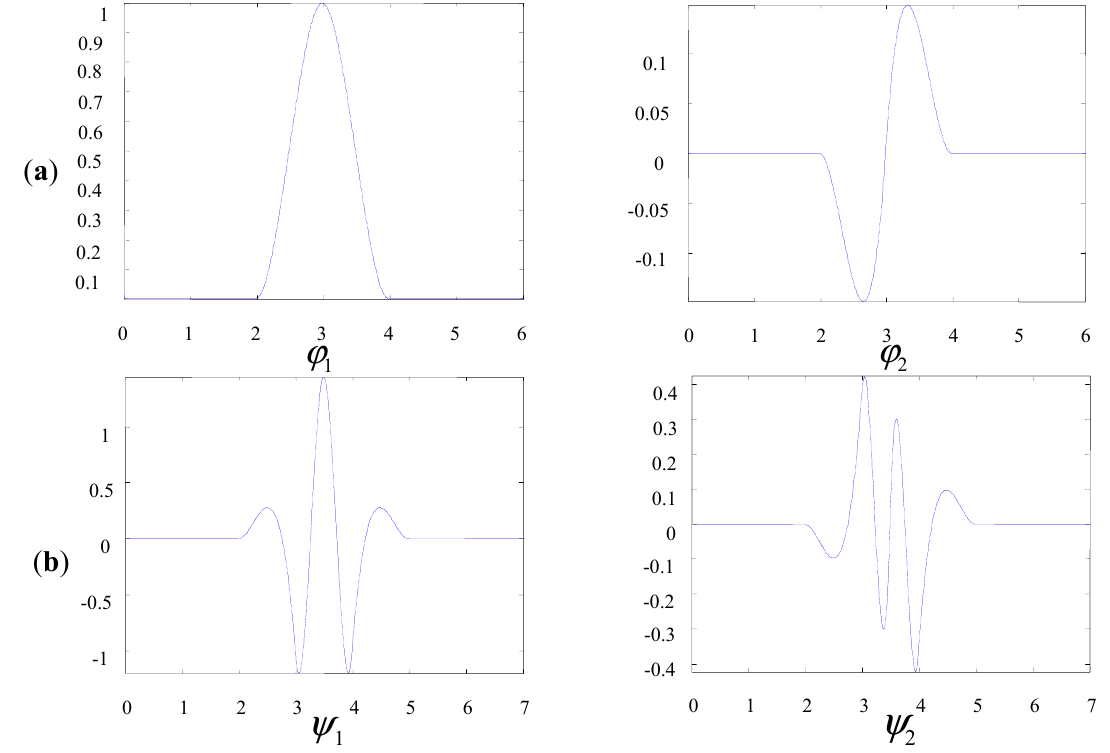
Figure 5. Hermite spline multiscaling functions and multiwavelet functions. ( a ) Multiscaling functions. ( b ) Multiwavelet